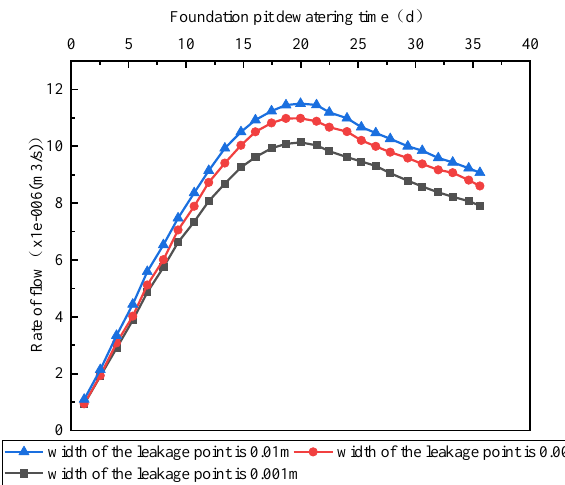
Figure 8. The curve of flow rate at the leakage and bottom of the envelope with precipitation time.